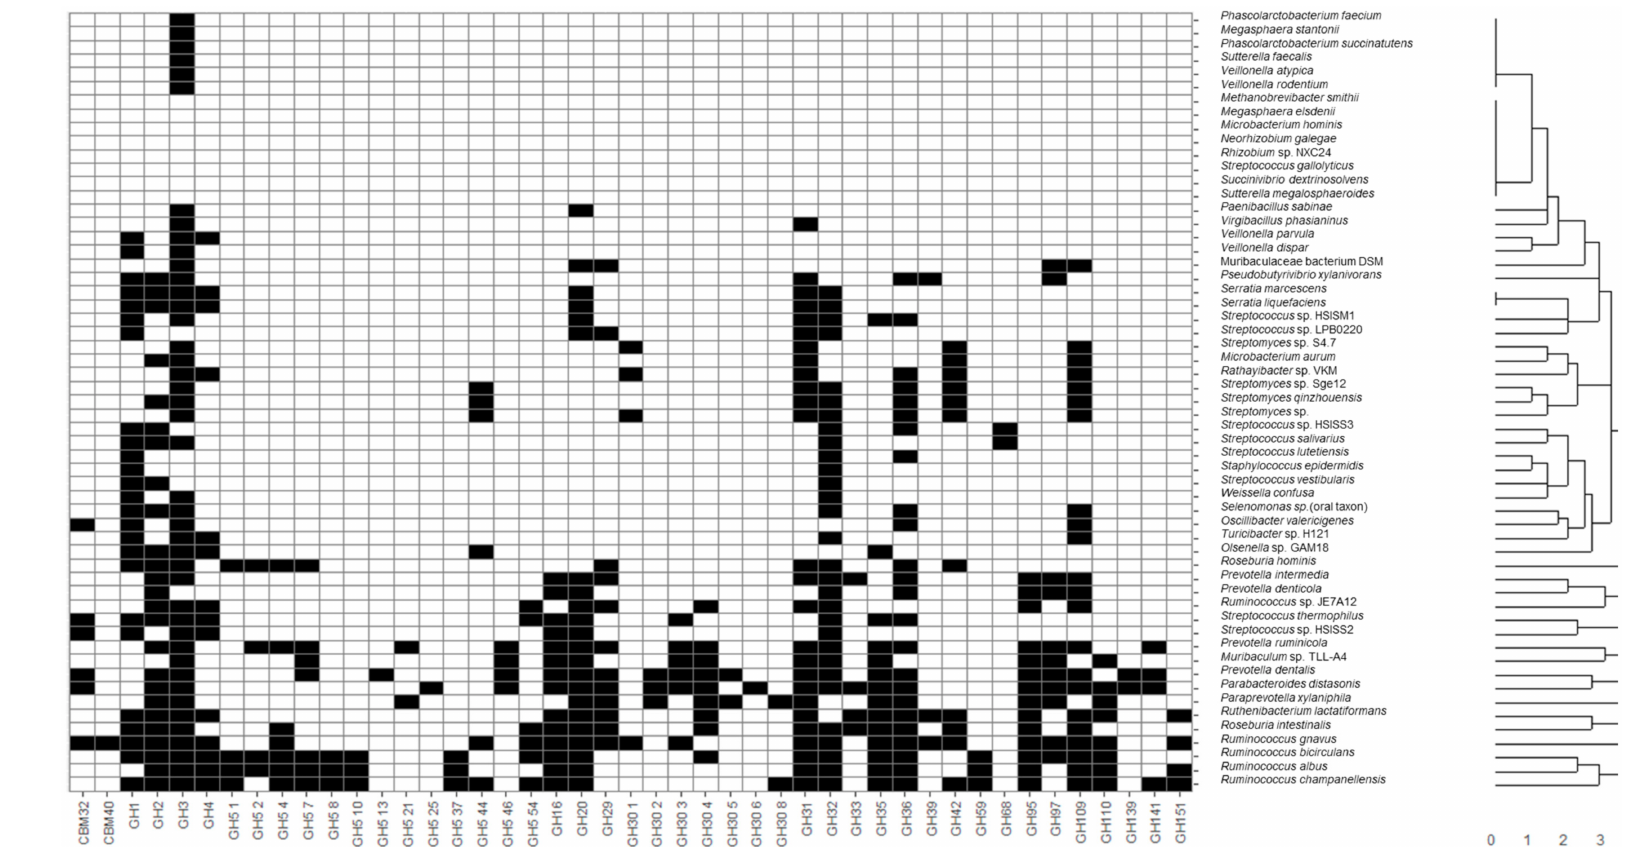
Figure 1. Heatmap showing the presence of different glycosidases (indicated as black cells) in metagenome-assembled genomes (MAGs). Specifically, glycosidases capable of degrading galacto- and fructo-oligosaccharides (GOS and FOS), as well as human milk oligosaccharides (HMOs), are illustrated. Black and white cells indicate the presence and absence of a specific CAZy family, respectively. Codes corresponding to the CAZy family of each enzyme were assigned. MAGs from Bifidobacterium are highlighted in black. (top) Glycosidase functional domains corresponding to CAZy families GH5 1, GH5 10, GH5 21, GH5 41, GH58 and GH68 were not identified in MAGs from the species shown in this section of the heatmap (vertical axis) and are not illustrated. (middle) Glycosidase functional domains corresponding to CAZy families GH5 5, GH5 7, GH5 8, GH5 10, GH5 18, GH5 21, GH5 38, GH30 2, GH30 6, GH30 9, GH68, GH139 and GH147 were not identified in MAGs from the species shown in this section of the heatmap (vertical axis) and are not illustrated. (bottom) Glycosidase functional domains corresponding to CAZy families GH5 5, GH5 18, GH5 22, GH5 38, GH5 41, GH30, GH30 9, GH58 and GH147 were not identified in MAGs from the species shown in this section of the heatmap (vertical axis) and are not